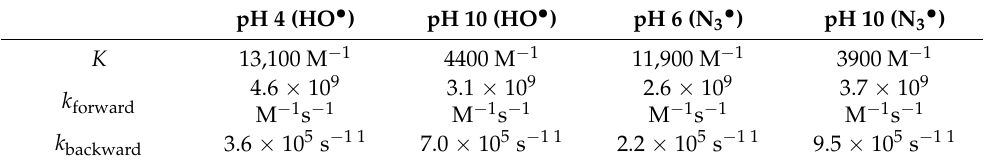
Table 1. Equilibrium constants ( K ) and rate constants involved in equilibria.